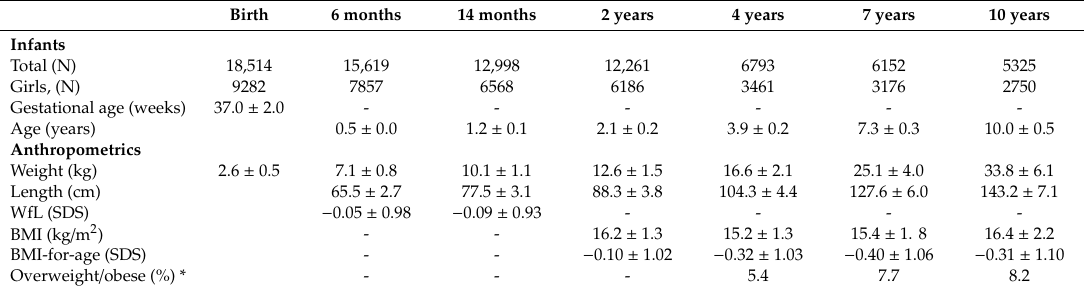
Table 2. Baseline descriptive statistics of twins from the Young Netherlands Twin Register (YNTR). Birth 6 months 14 months 2 years 4 years 7 years 10